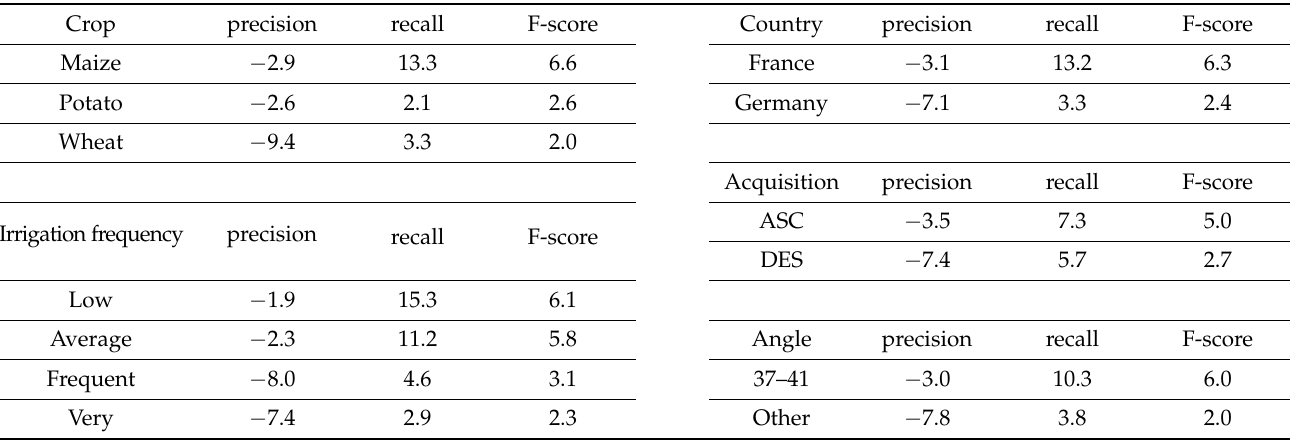
Table 5. Comparison of scores between the initial bucket soil water budget and the force-restore— FR—approach (score FR minus score Bucket), according to different configurations (Crop, Country, Irrigation frequency, Acquisition,